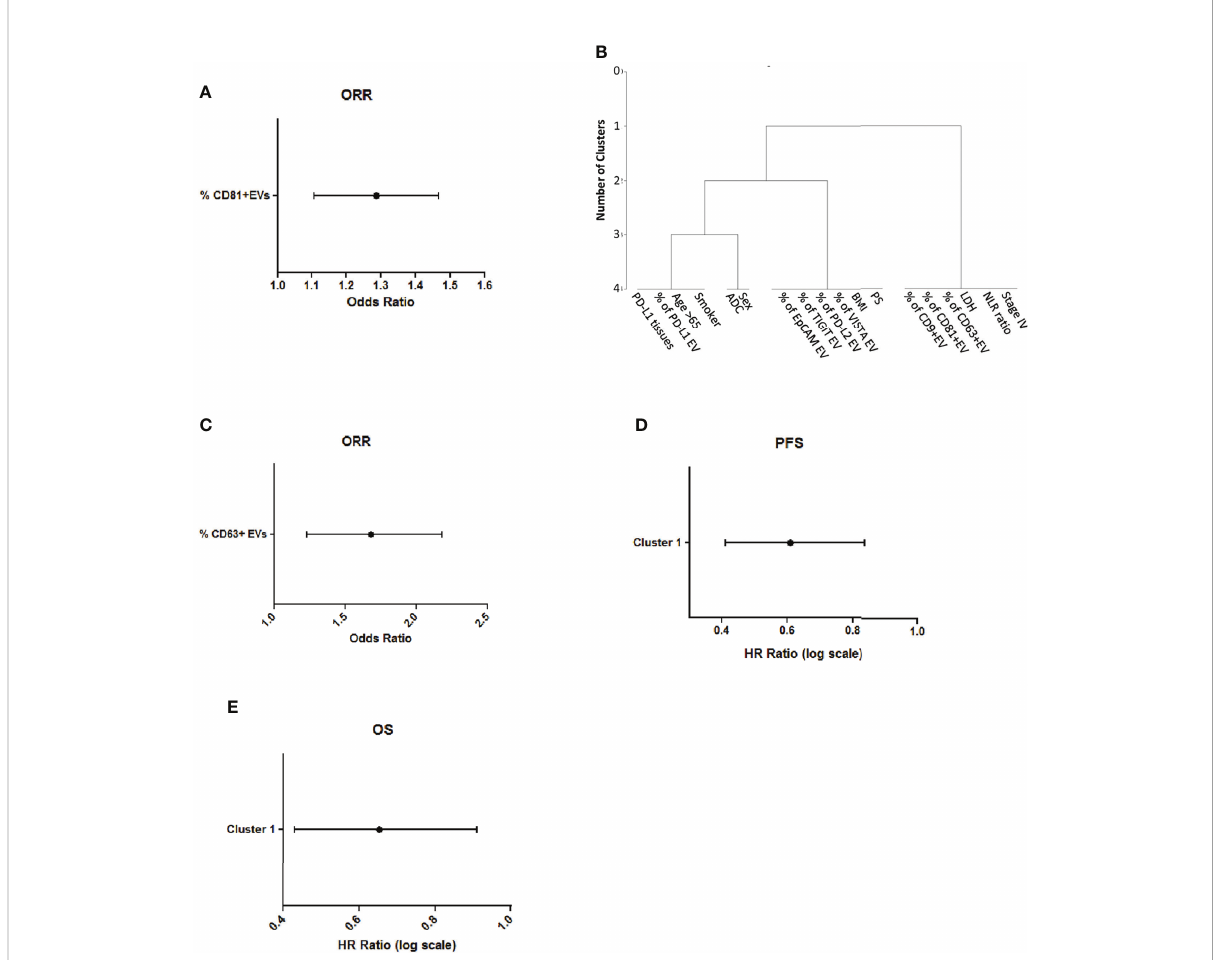
FIGURE 5 CD81 levels on circulating EVs are associated to better response and survival (A) Multivariable logistic analysis of association between variables selected from univariable analysis (B) Representation of cluster procedure selection variables in our cohort of patients (C) Association of CD63 + EVs with ORR (D) Association of cluster 1 with Progression Free Survival in lung cancer patients (E) Association of cluster 1 with Overall Survival of lung cancer